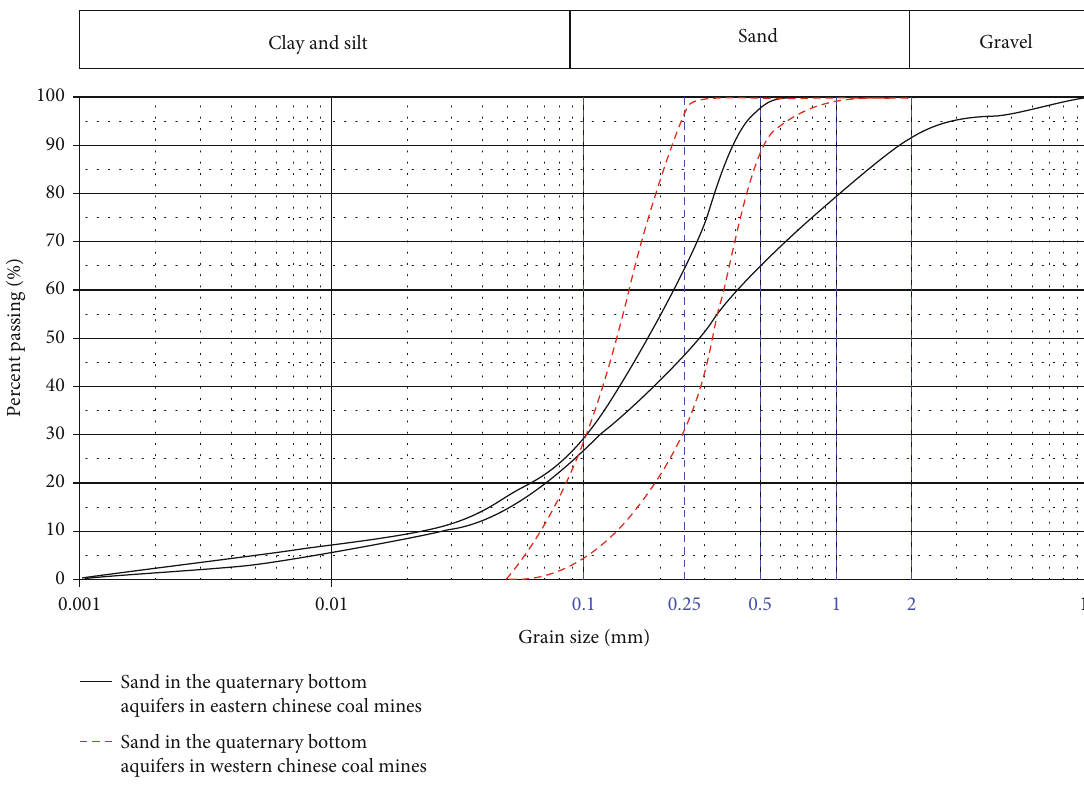
Figure 3: Grain size distribution of sand from coal mines.